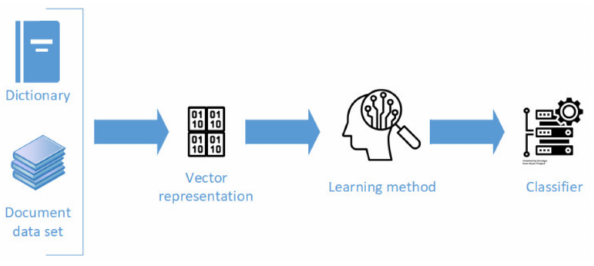
Figure 3. Proposed workflow.